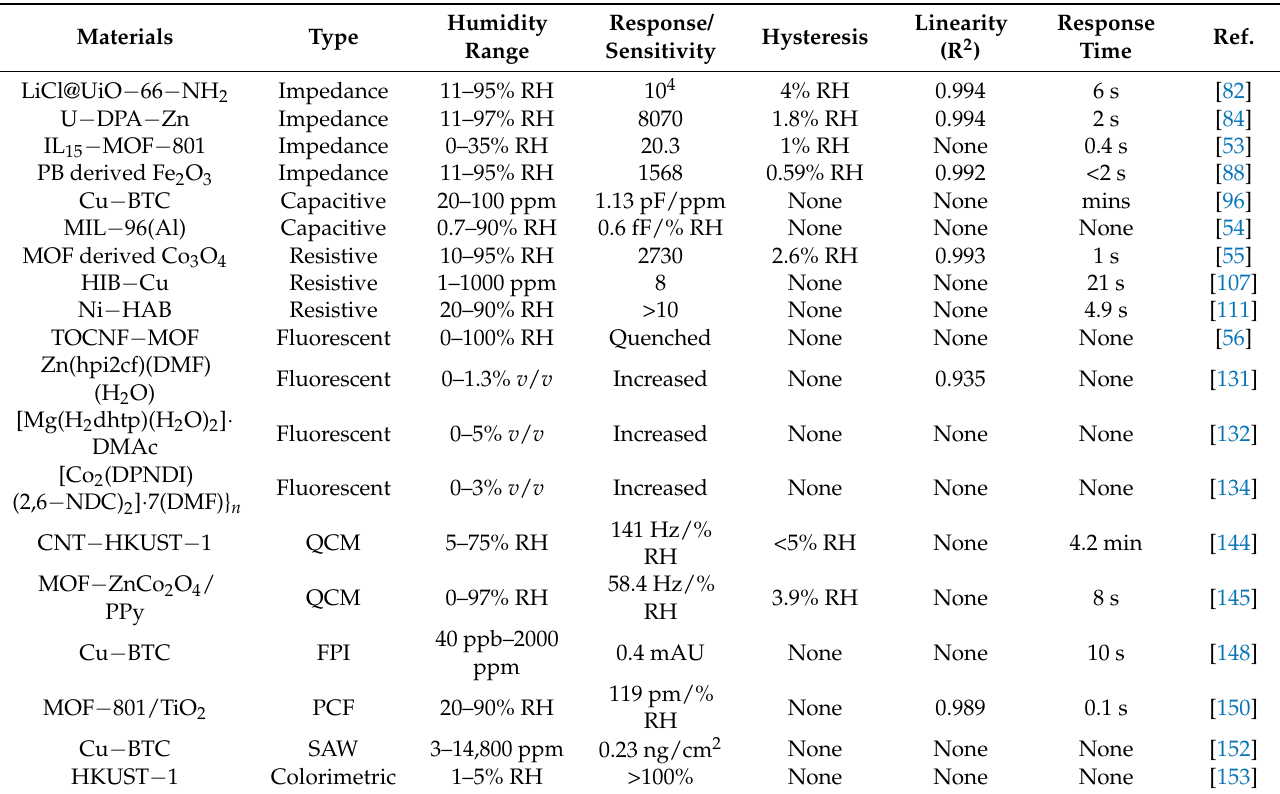
Table 7. Sensing properties of different MOF − based humidity